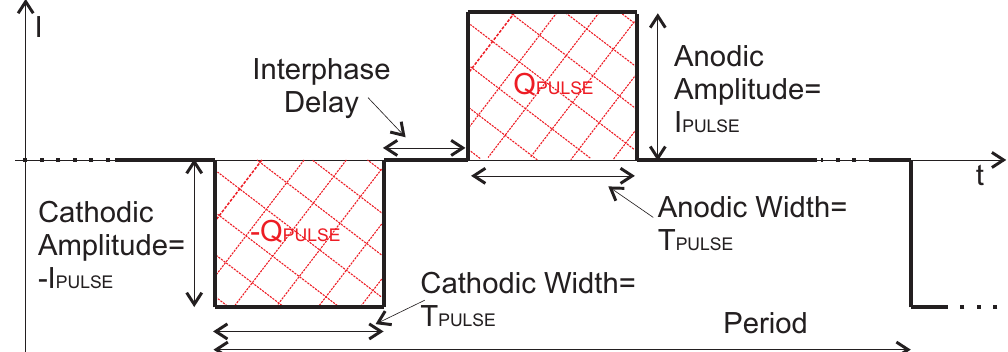
Figure 1. Pictorial representation of a biphasic current stimulation. Typical electric characteristics are